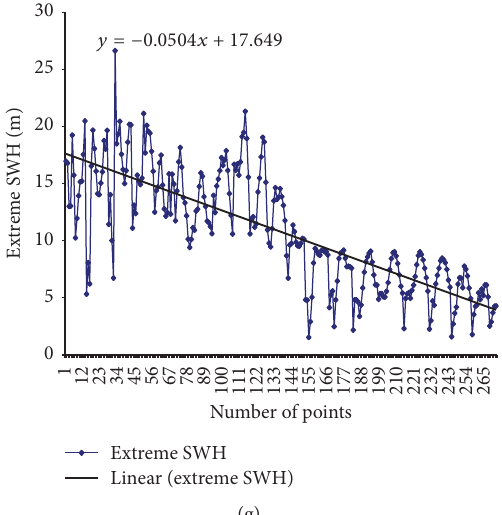
Figure 12: Temporal trends in 100-year return period, 99th-percentile wave height calculated using linear regression from the extreme value analysis of (a) 1976–1980, (b) 1980–1984, (c) 1984–1988, (d) 1988–1992, (e) 1992–1996, (f) 1996–2000, and (g) 2000–2005 segments (periods) for the